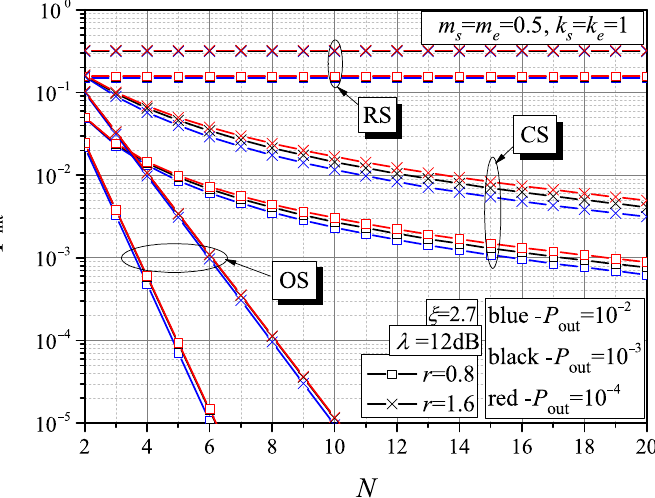
Figure 7. The intercept probability versus the outage probability according to SRT.